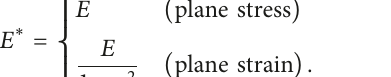
Figure 3: Elements selection for the interaction integral near the crack